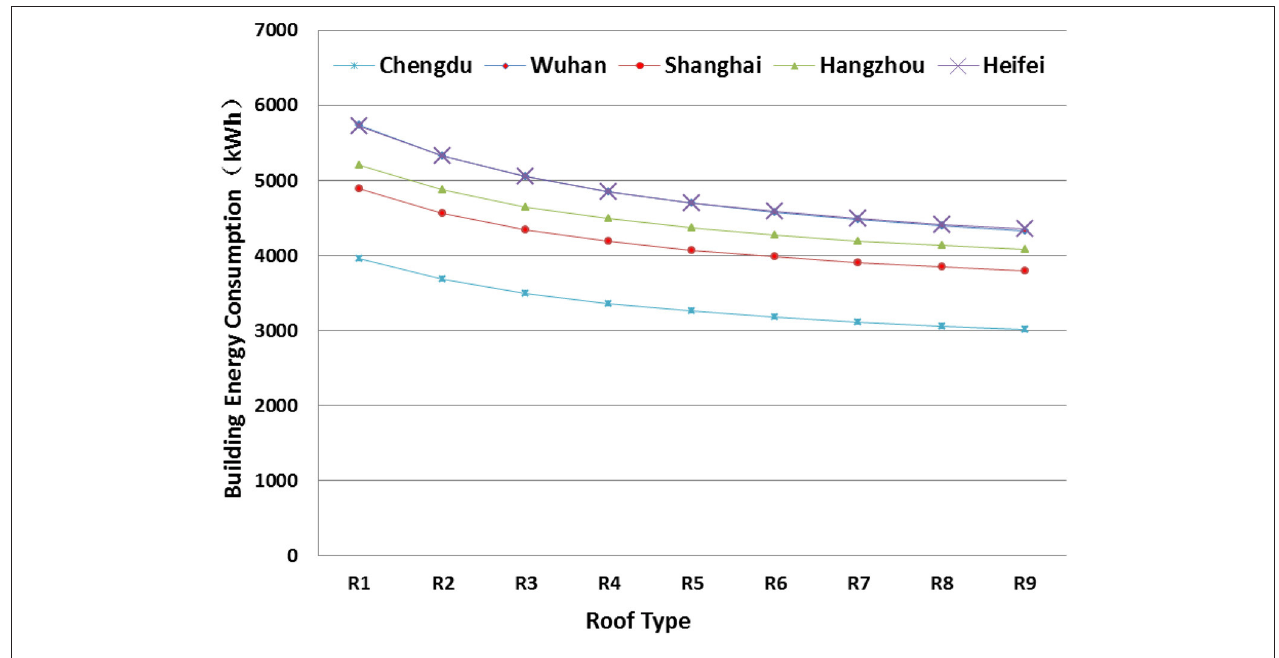
FIGURE 11 | Sensitivity analysis of roof type on annual energy consumption.